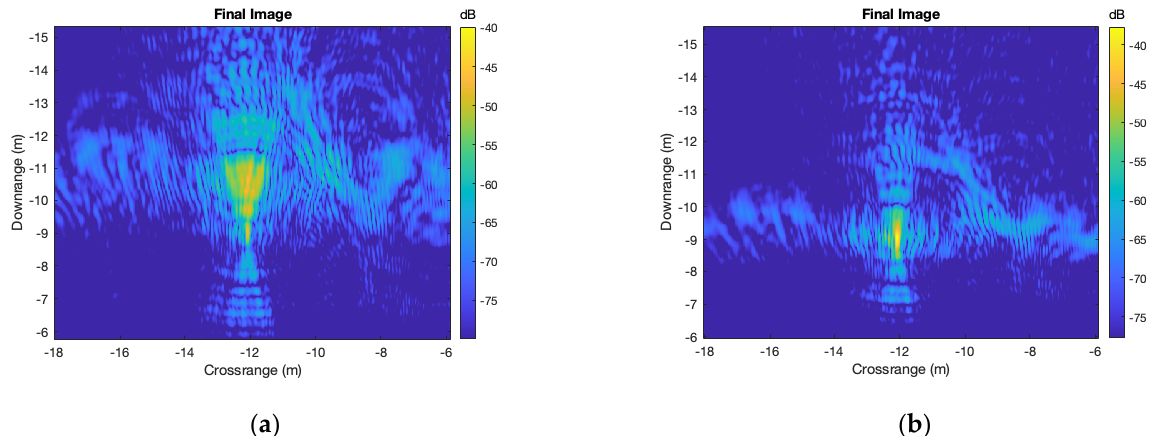
Figure 7. SAR image of first corner reflector ( a ) before phase correction and ( b ) after phase correction.